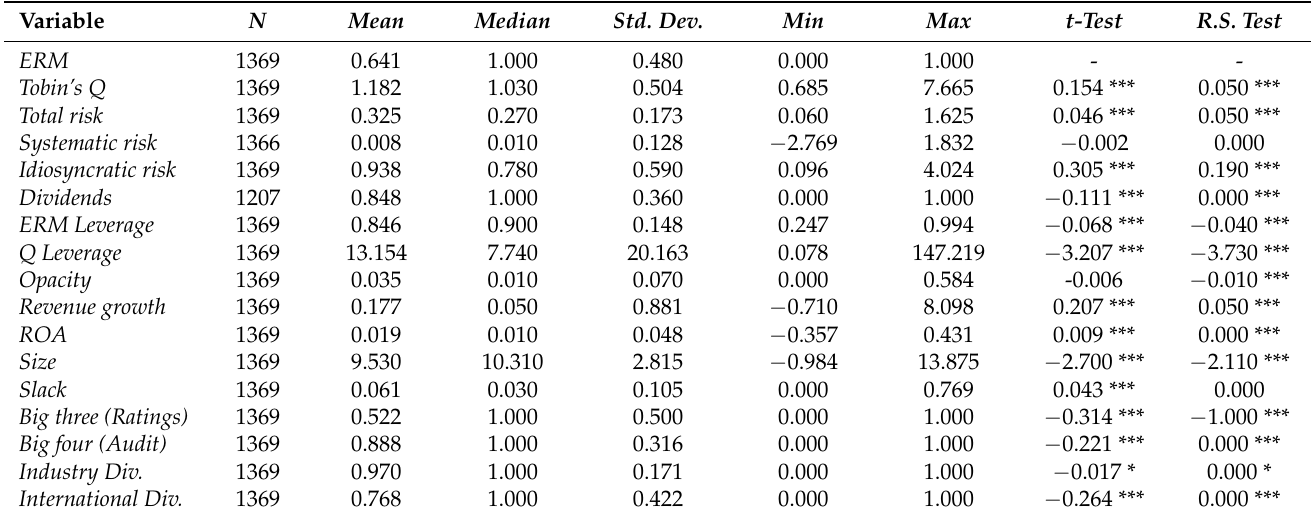
Table 2. Descriptive